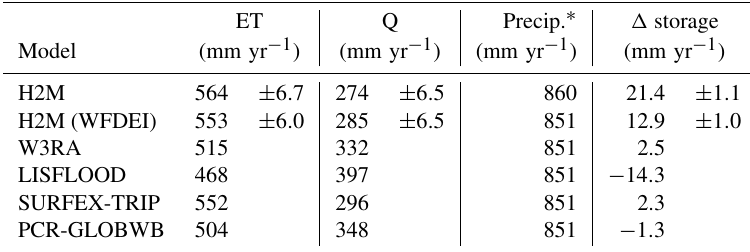
Table 4. Global yearly evapotranspiration (ET), grid cell runoff (Q), precipitation (Precip.), and storage change ( (cid:49) storage) over the period from 2003 to 2012 for the hybrid hydrological model (H2M) and a set of physically based global hydrological models (GHMs). The H2M was forced with the GPCP precipitation product (H2M) and the WFDEI data (H2M (WFDEI)) independently. The latter dataset is also used by the GHMs. The values for H2M and H2M (WFDEI) represent the mean ± the standard deviation across all cross-validation runs. Values from the common land-mask of all models were considered. ET Q Precip.